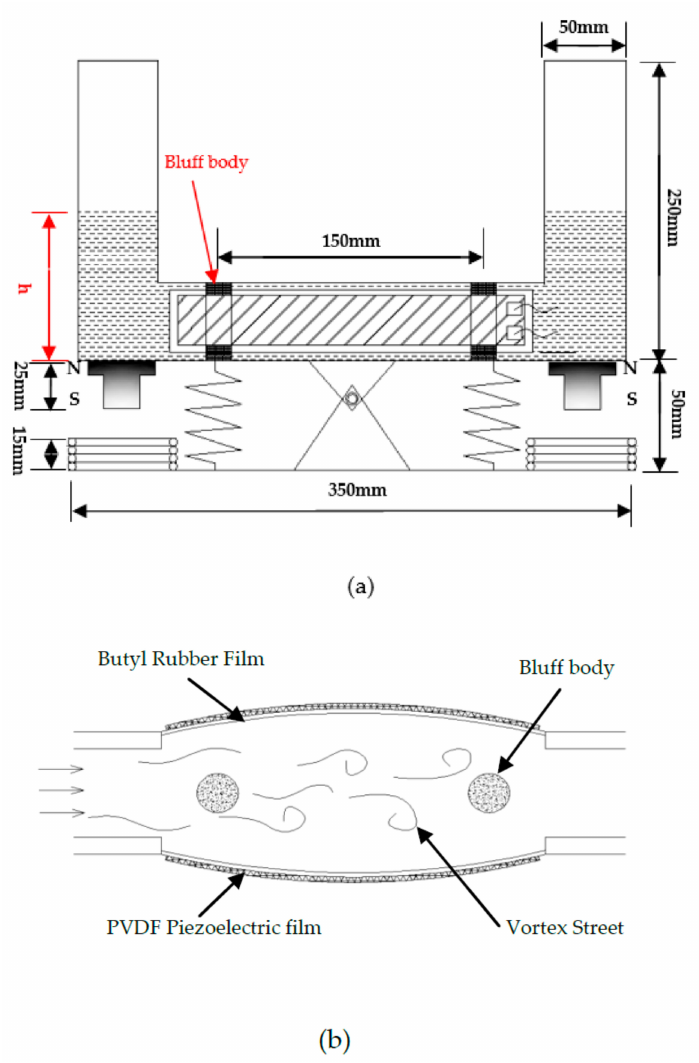
Figure 1. The hybrid energy harvester’s architecture: ( a ) Diagram of the composition structure; ( b ) Schematic diagram of the vortex